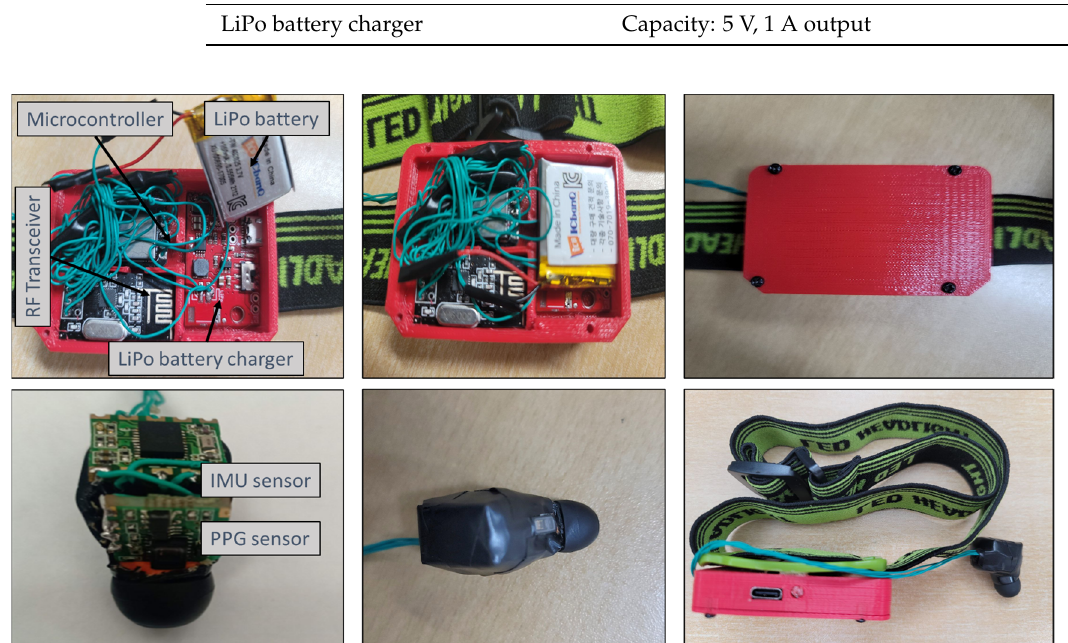
Figure 2. Final design of the motherboard interconnected with the earbud board.